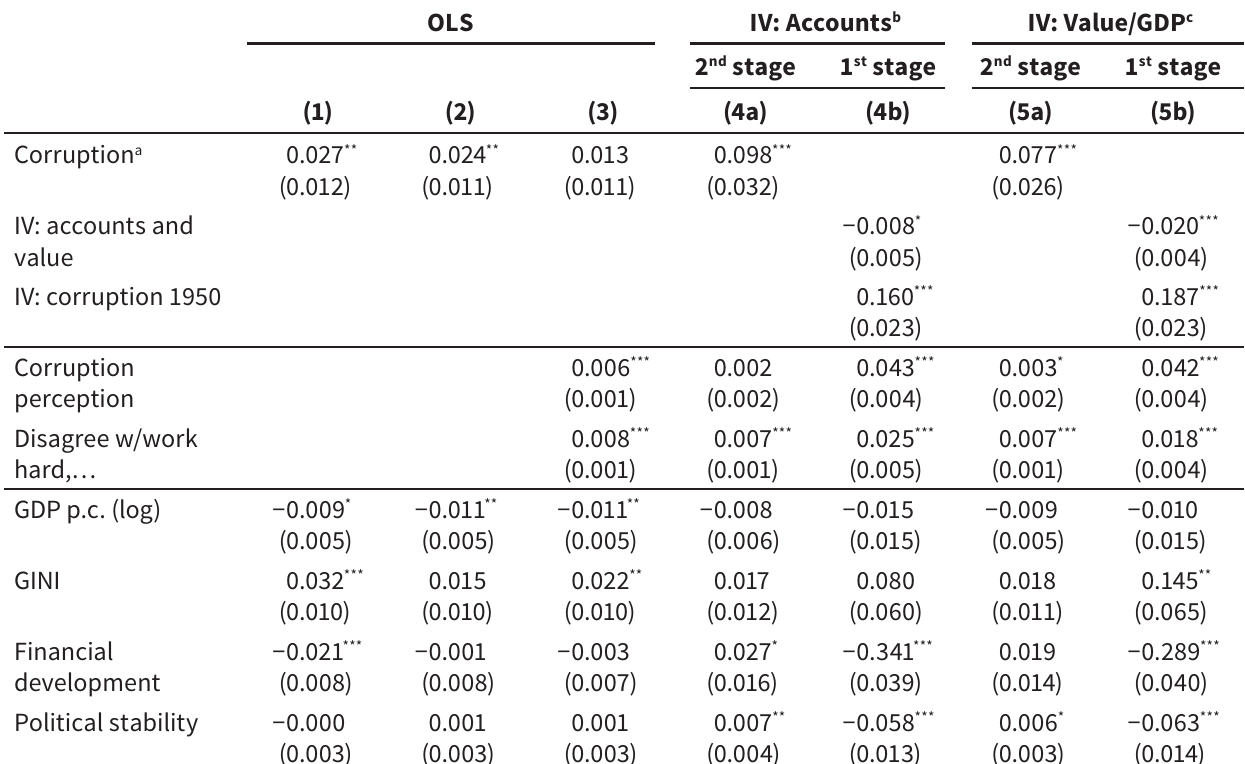
Full regression table for plans to emigration within the next 12 months (inverse of CPI corruption